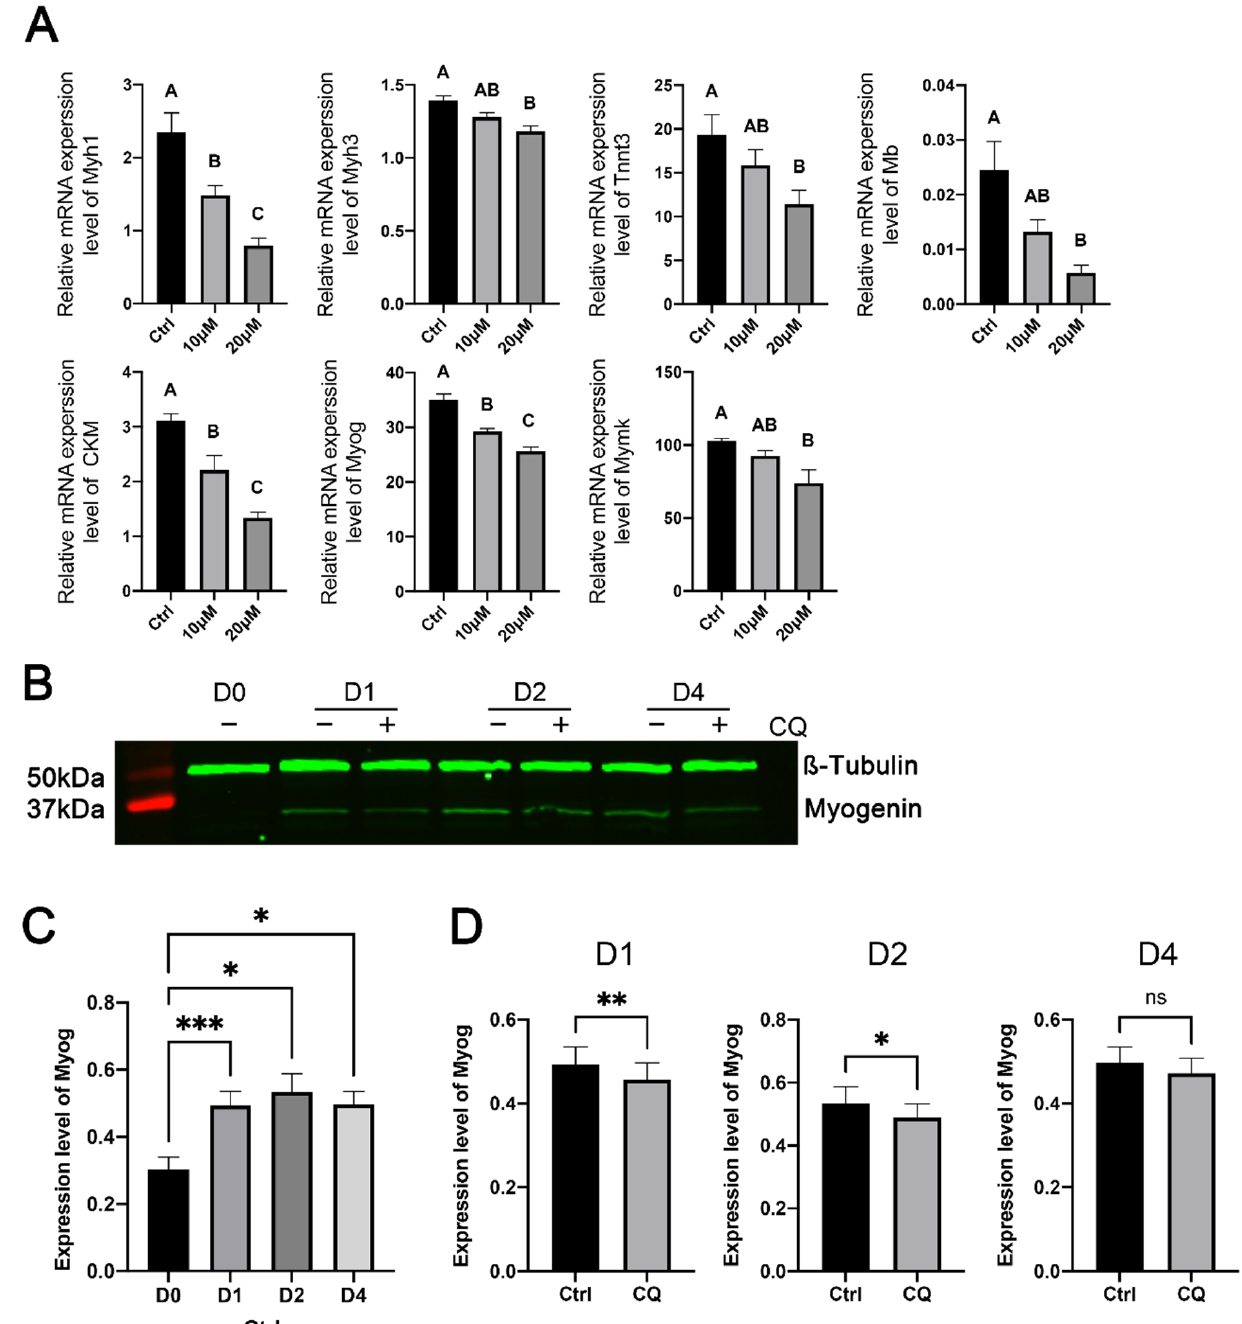
Figure 6. Effects of inhibiting autophagy with chloroquine on the expression of selected muscle- specific genes in C2C12 cells during myogenic differentiation. C2C12 cells were cultured in differ- entiation medium in the presence of 10 or 20 μ M chloroquine for 4 days. Control (ctrl) C2C12 cells were cultured in differentiation medium without chloroquine. ( A ) Relative mRNA expression levels. Bars not sharing the same letter label are different ( p < 0.05, n = 6), based on Tukey’s test. ( B ) Representative Western blots of myogenin. ( C ) Comparison of myogenin protein expression levels in C2C12 cells between day (D) 0 and days 1, 2, and 4 of differentiation. * and *** indicate p < 0.05 and 0.01, respectively, based on Dunnett’s test ( n = 5). ( D ) Comparison of myogenin protein expression levels in C2C12 cells between chloroquine and control. *, ** and ns indicate p < 0.05, 0.002 and >0.05, respectively, based on t -tests ( n = 5). Data were log-transformed for normality prior to statistical